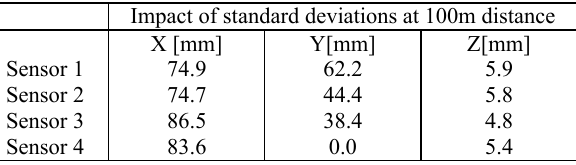
Table 3. Impact of standard deviations from relative orientation on 3D coordinates at 100m